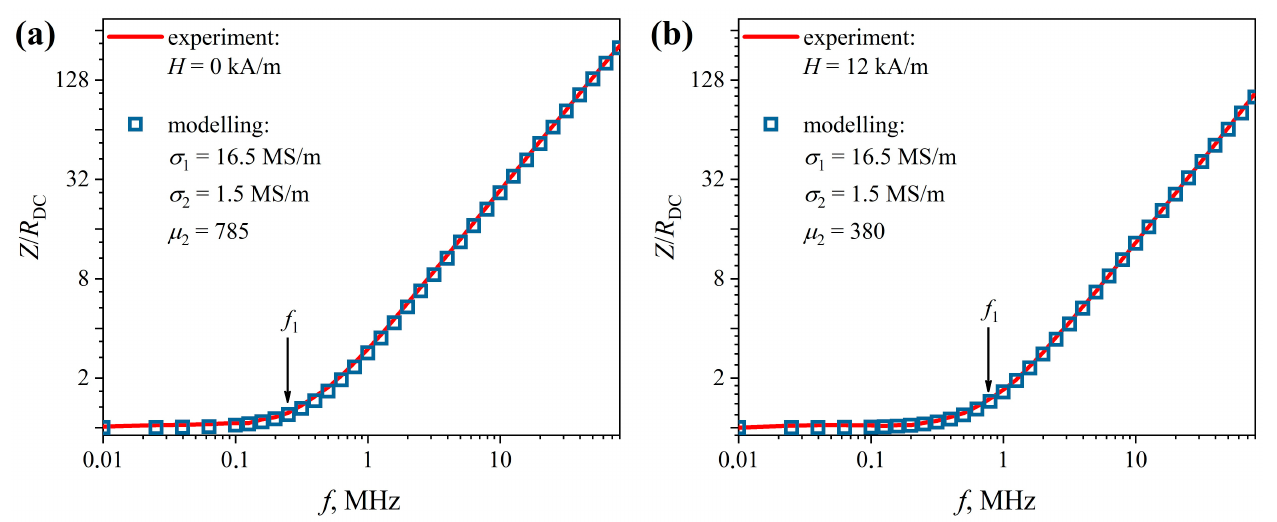
Figure 5. Dependences of the reduced impedance Z / R DC of the CuBe/FeCoNi composite wire on the AC frequency, f , obtained at the external magnetic field strength 0 ( a ) and 12 kA/m ( b ). It is clear from expressions (1) and (2) that the horizontal section of the Z ( f )/ R DC dependence corresponds to the situation when the skin layer thickness δ is greater than the wire radius. Therefore, for f < f 1 , the impedance modulus Z ≈ R DC . For f > f 1 , the skin layer